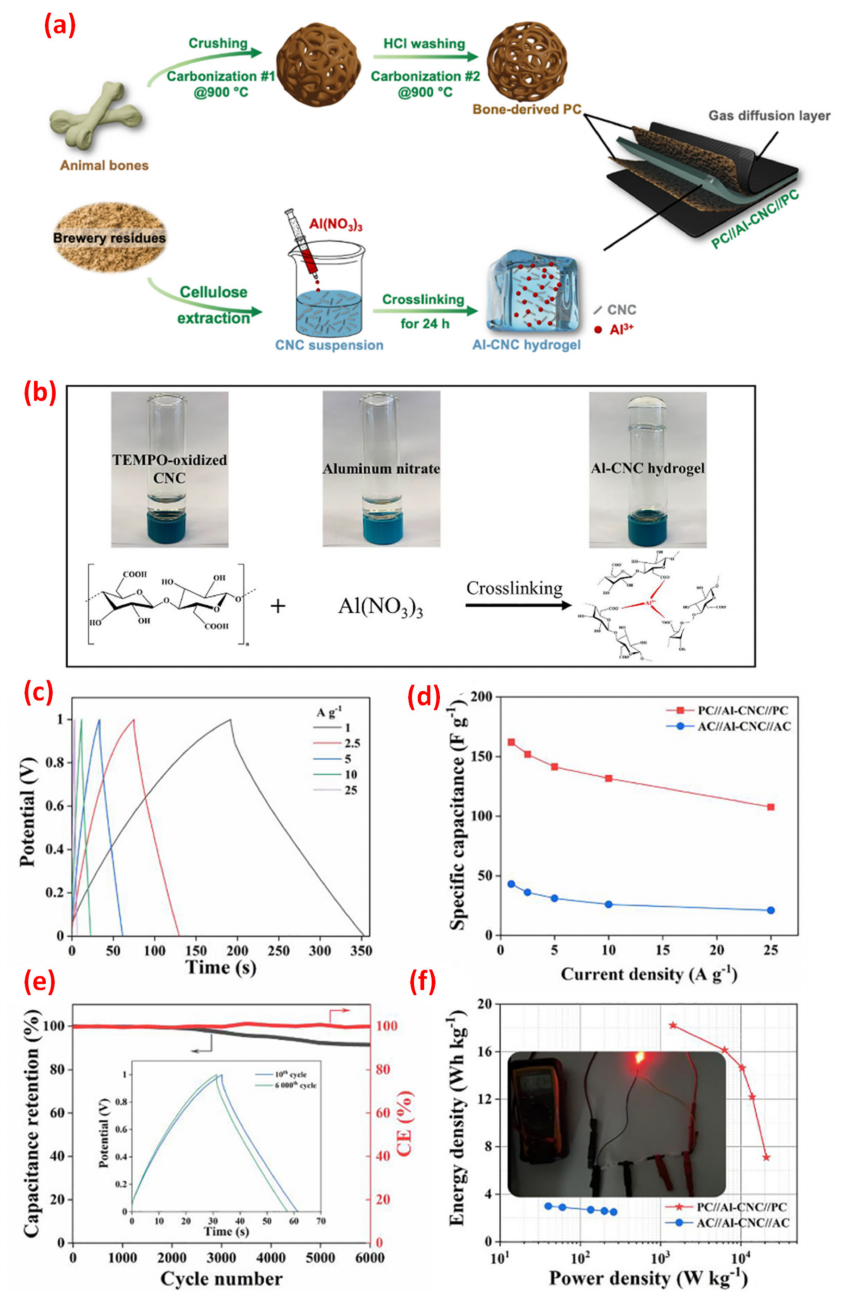
Figure 8. ( a ) The preparation of PC//Al − CNC//PC as a flexible supercapacitor, ( b ) The preparation of TEMPO mediated Al − CNC hydrogel, ( c – f ) The electrochemical properties, such as the GCD curve, specific capacitance, stability analysis and Ragone plot, of the PC//Al − CNC//PC electrode. Adapted with permission from [109]. Copyright 2022